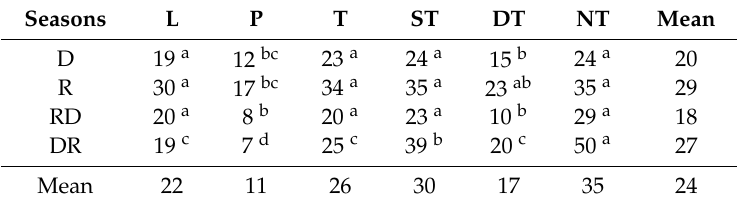
Table 4. Earthworm abundance (ind m − 2 ) at di ff erent soil tillage and four type of